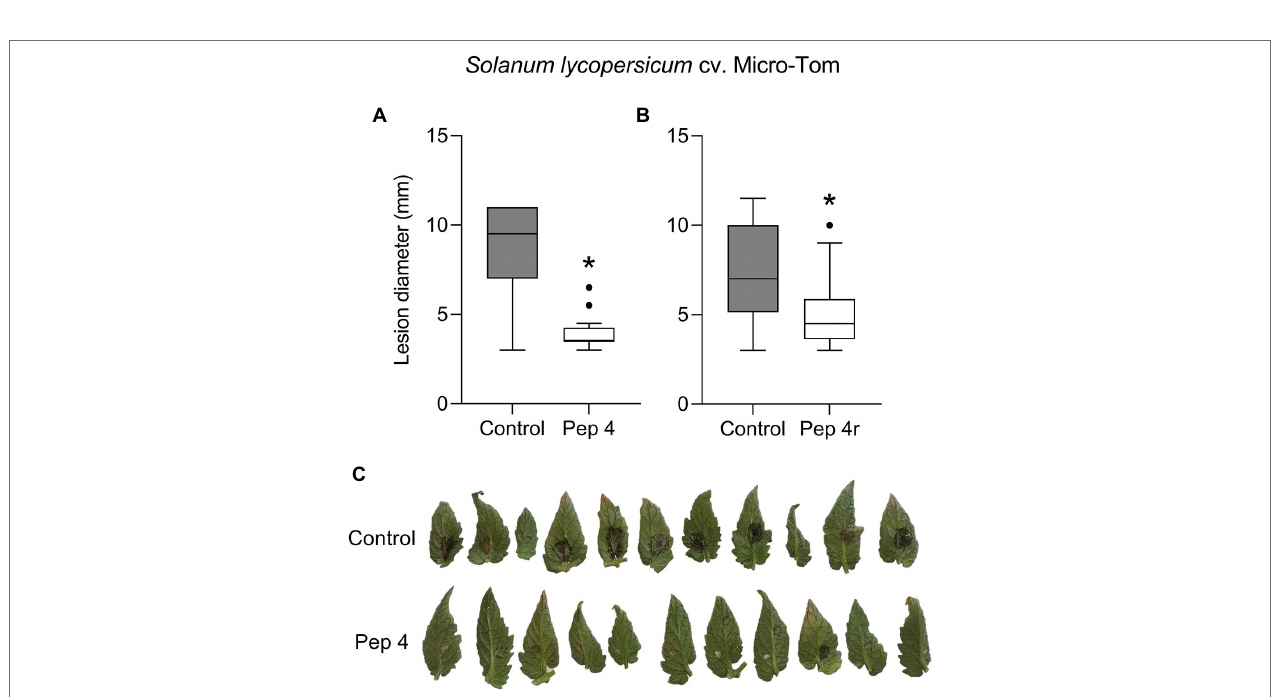
FIGURE 3 | Trichogin GA IV-derived peptides Pep 4 (A,C) and Pep 4r (B) protect tomato from Botrytis cinerea infection up to 5 days after treatment. Solanum lycopersicum cv. Micro-Tom leaves were treated on the lower (abaxial) surface by spraying 50 μ M peptide solution in water, and drop inoculated 120 h later with a conidial suspension of B. cinerea . Conidia were applied on the abaxial (peptide-treated) leaf surface. Lesion diameters were measured 3 days after infection. Control, leaves treated with water. Values from 11 to 13 biological replicates (A) or 12–16 biological replicates (B) are reported as Tukey boxplots. Data were analyzed by t -test ( p < 0.05). Statistically significant differences are shown by asterisk. Representative pictures concerning Pep 4 protection from B. cinerea infection are shown (C) .